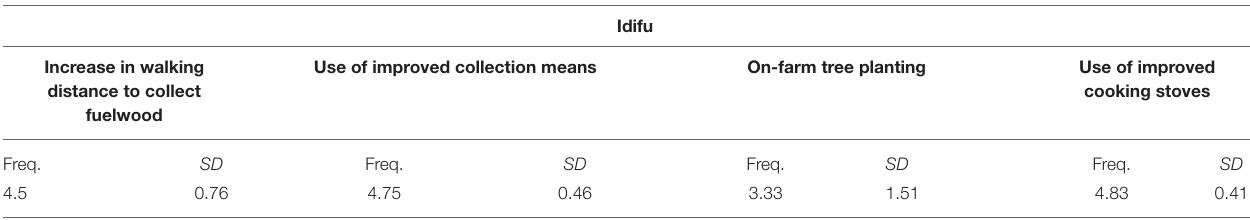
TABLE 7 | Results from the frequency assessment of